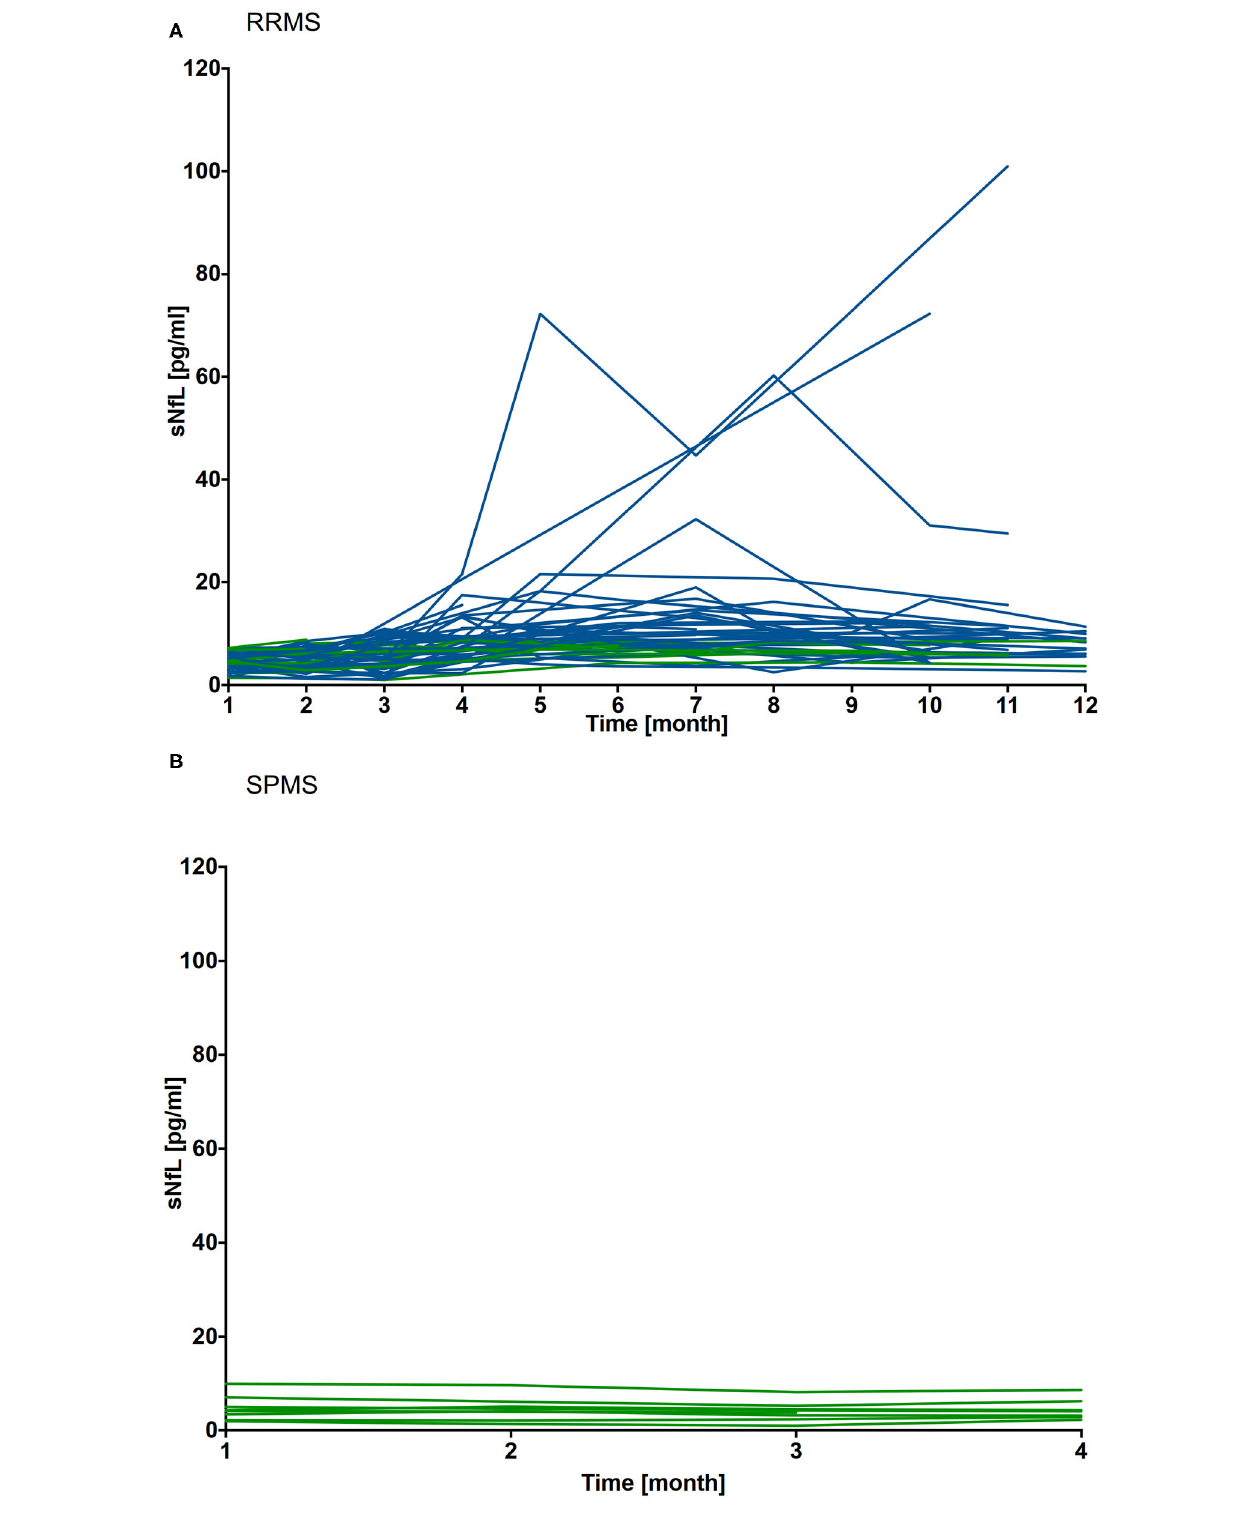
FIGURE 4 | Individual sNfL levels after cessation of NAT treatment in RRMS ( n = 46) and SPMS ( n = 9) patients. sNfL levels were assessed during washout period up to 12 months in RRMS patients (A) and for 4 months in SPMS patients (B) . sNfL value measured 4 weeks after NAT cessation was defined as individual steady state (SS) value. A relevant increase of sNfL was defined as sNfL values ≥ SS + 2SD. Individual sNfL courses are depicted, relevant sNfL increase are labeled blue, patients without an increase are depicted green.